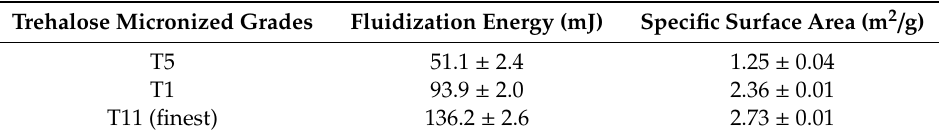
Table 2. Fluidization energy and specific surface area measured for trehalose micronized fine grades. ( n ≥ 3, Mean ±